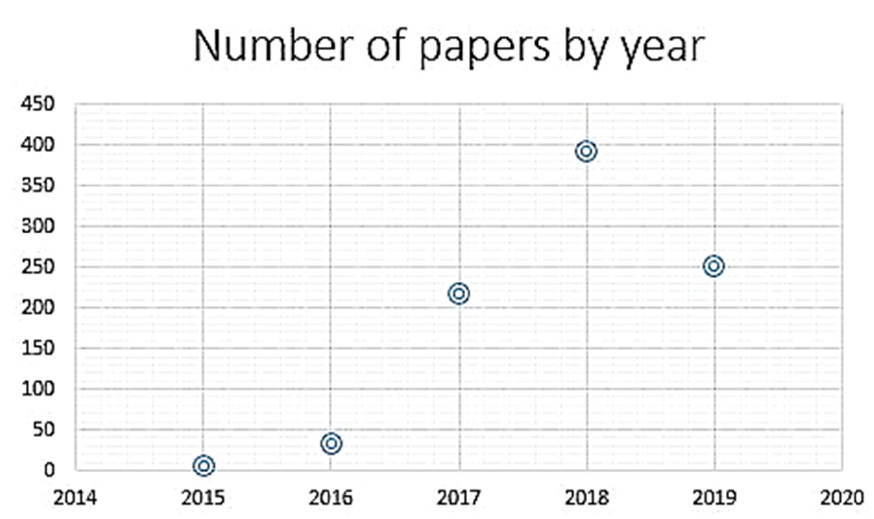
Figure 7. Number of papers about LoRa and IoT from 2015 to 2019.